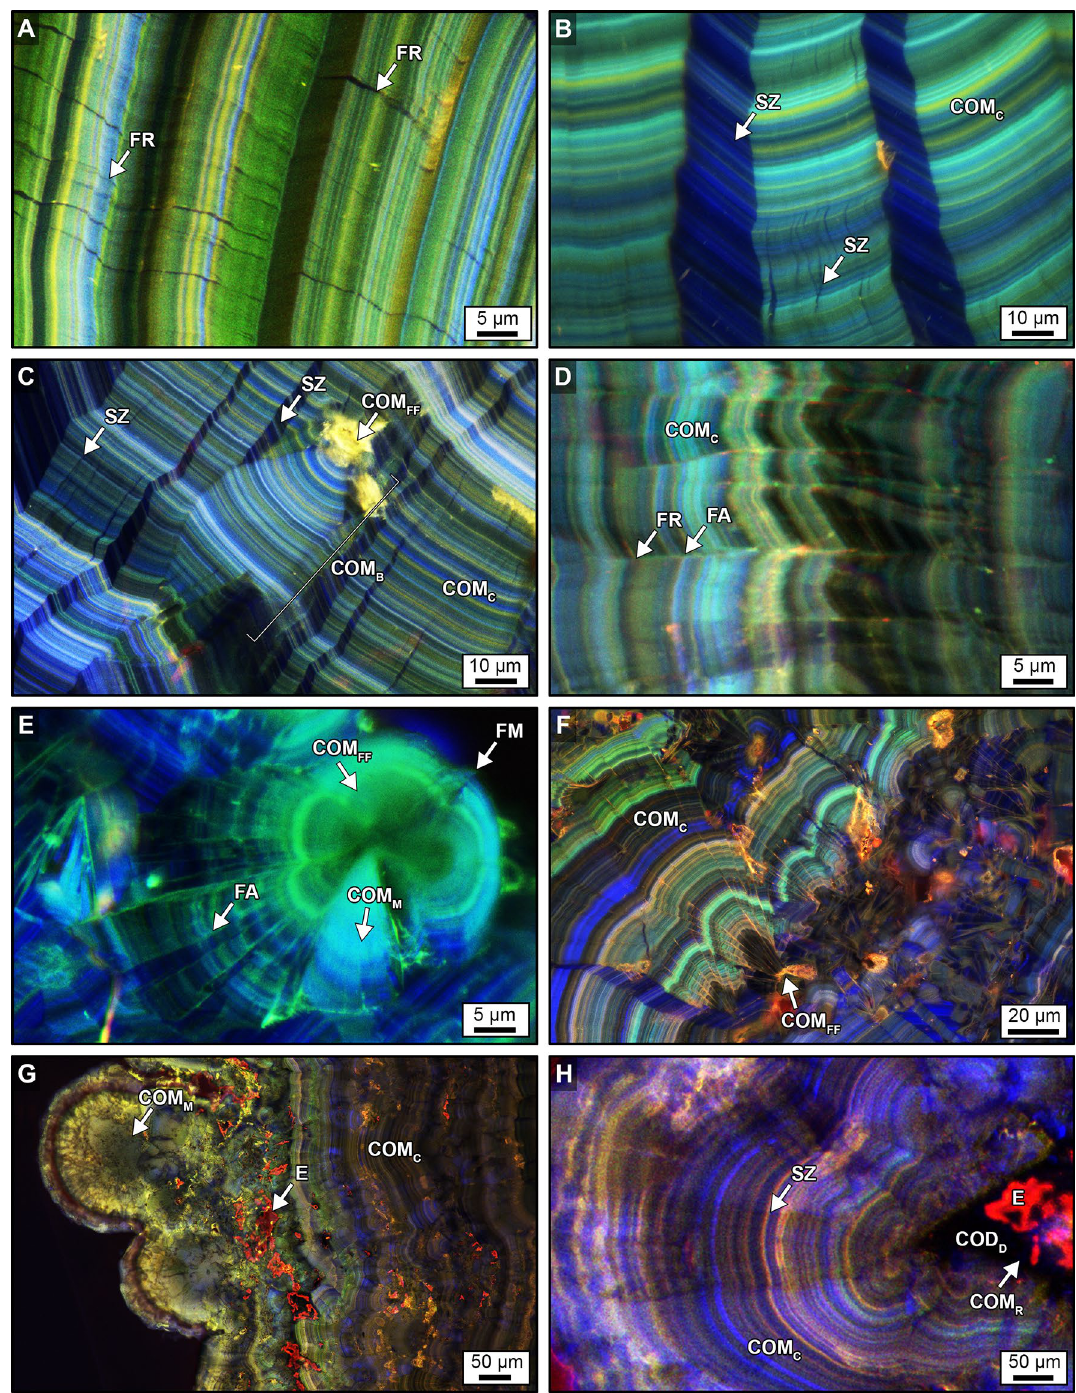
Figure 3. Original crystalline architecture of calcium oxalate (CaOx) PCNL-derived fragments. ( A,D,E ) SRAF images. ( B,C,F,G,H ) CAF images. Labels indicate: FR fracture, FA fault L lath, SZ sector zone, COM FF free-floating COM, COM C COM cortex, COM B bundles of COM radiating from a COM FF , COM M mimetic replacement COM, COM R replacement COM, COD D dissolved COD; and E, red AF embedding epoxy. Image locations shown in Figs. 2B–D and 4C and corresponding T-PMT images presented in Supplementary Fig.